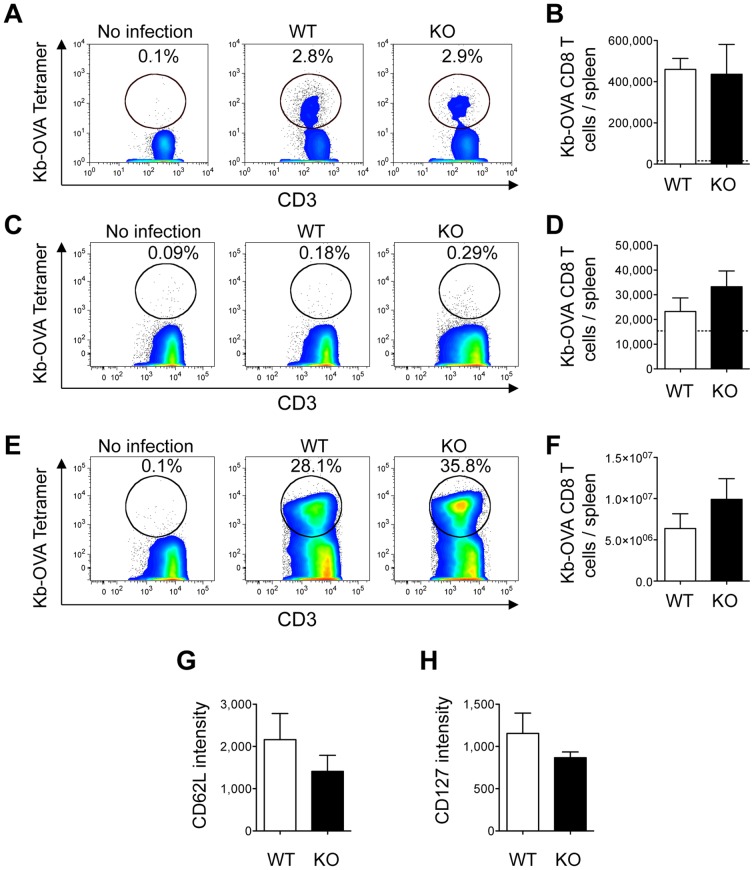
Normal effector and memory CD8+ T cell response to Listeria in KSR1-deficient mice.WT and KSR1-/- mice were infected with 2×103 cfu of Lm-OVA, and presence of OVA epitope specific CD8+ T cells in the spleen was analyzed by flow cytometry 7 (A, B) and 30 (C, D, G, H) days after infection. 30 days after Lm-OVA infection, mice were challenged with 105 cfu of Lm-OVA and presence of OVA epitope specific CD8+ T cells in the spleen was assessed 5 days later (E, F). A, C, E: Percentage of Db-GP33 Tetramer positive cells in CD8+ T cells. Plots are representative of two experiments with 3–8 mice per group. B, D, F: Number of Db-GP33 Tetramer+ CD8+ T cells per spleen. Dashed line represents average numbers in naive mice and mice infected with Lm. G, H: CD62L and CD127 expression in Db-GP33 Tetramer+ CD8+ T splenocytes 30 days after Lm-OVA infection. Data is presented as mean + SEM and is representative of two experiments with 3–8 mice per group. There were no significant differences between WT and KO mice (t-test).